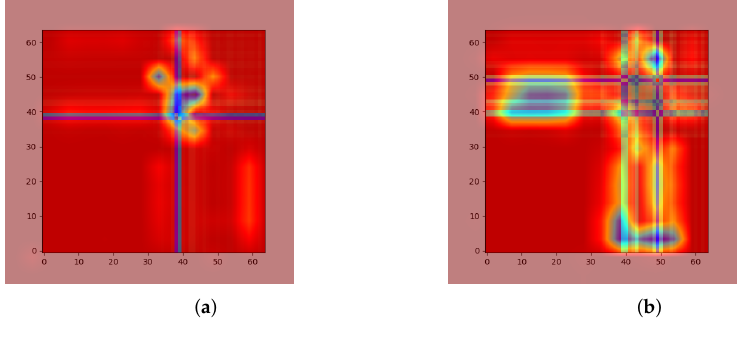
Figure 13. 2D SAM-CNN feature